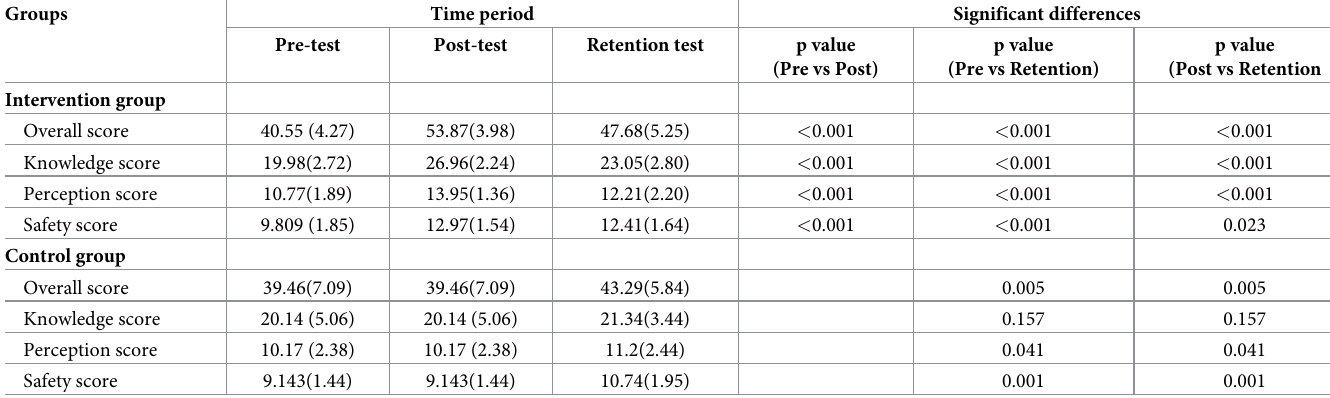
Table 4. Table showing the changes of scores of the students in intervention groups: Pre-test (before the rabies education), post-test (immediately after education) and retention (three months after rabies education).